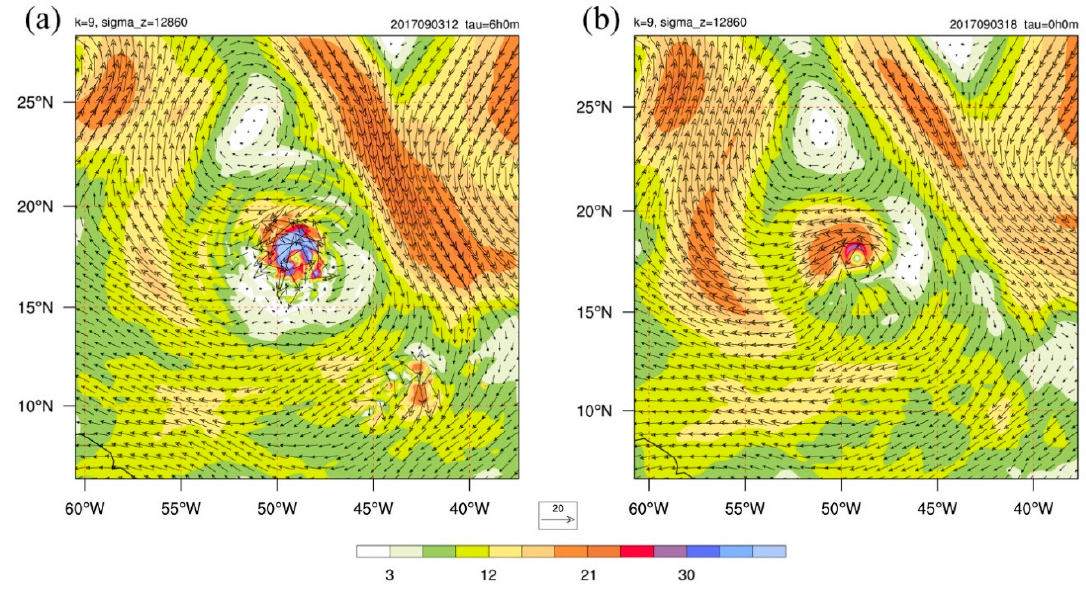
Figure 8. Domain 3 z = 12,860 m wind vectors (m s − 1 , color bar and 20 m s − 1 length indicated by arrow at bottom) at 18 UTC 3 September from ( a ) six-hour COAMPS-TC forecast from cold-start initial conditions in Figure 6a that might be used as warm-start initial conditions versus ( b ) the cold-start initial conditions with a bogus vortex that are actually used for Control 72 h forecast.